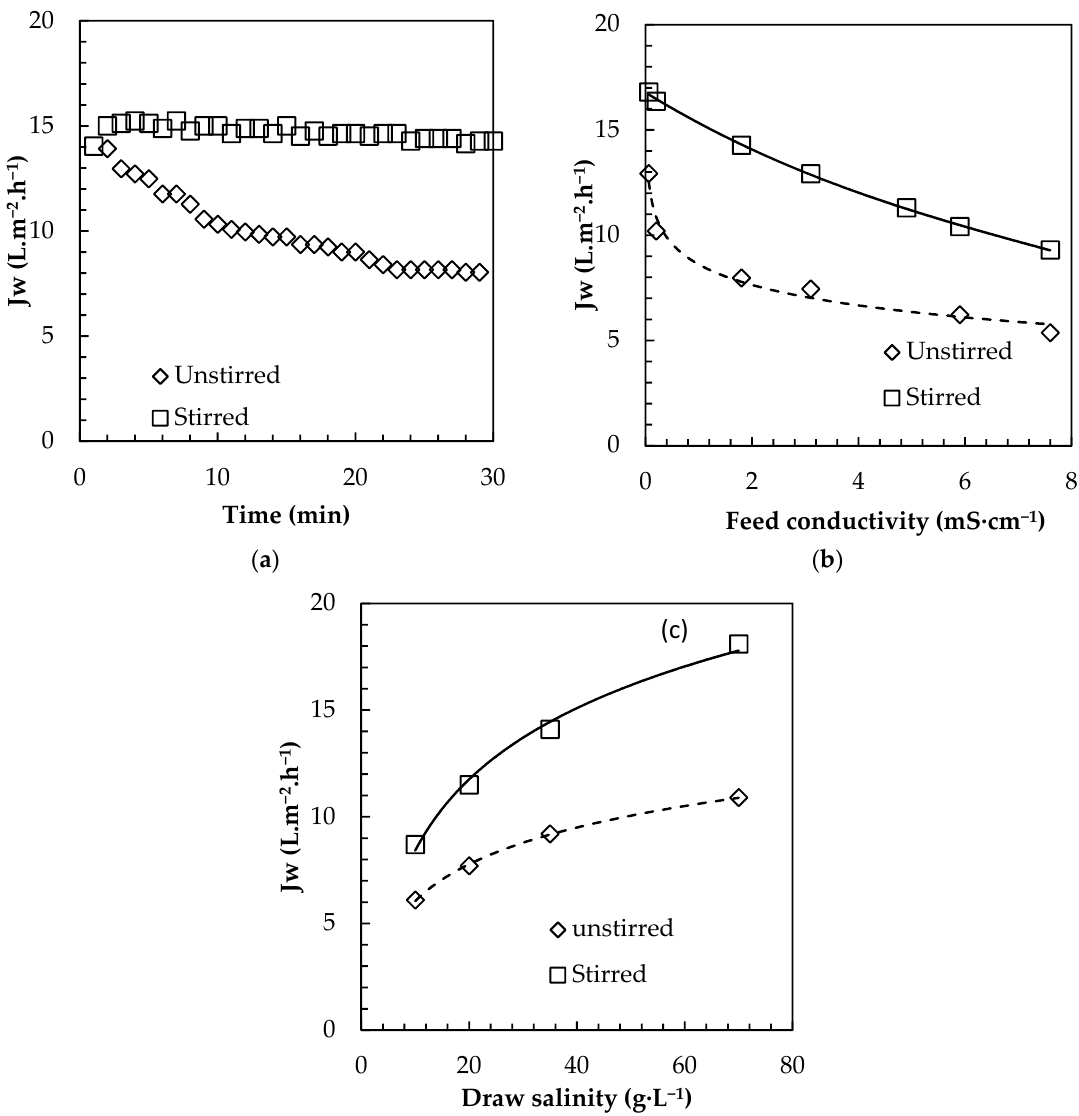
Figure 7. Impact of stirring on ( a ) instantaneous water flux, and average permeation flux (during 30 min) ( b ) for different feed conductivities ( c ) and different draw salinities (DI water as feed, 35 g·L − 1 SW as draw solution, U shape large mesh plate).